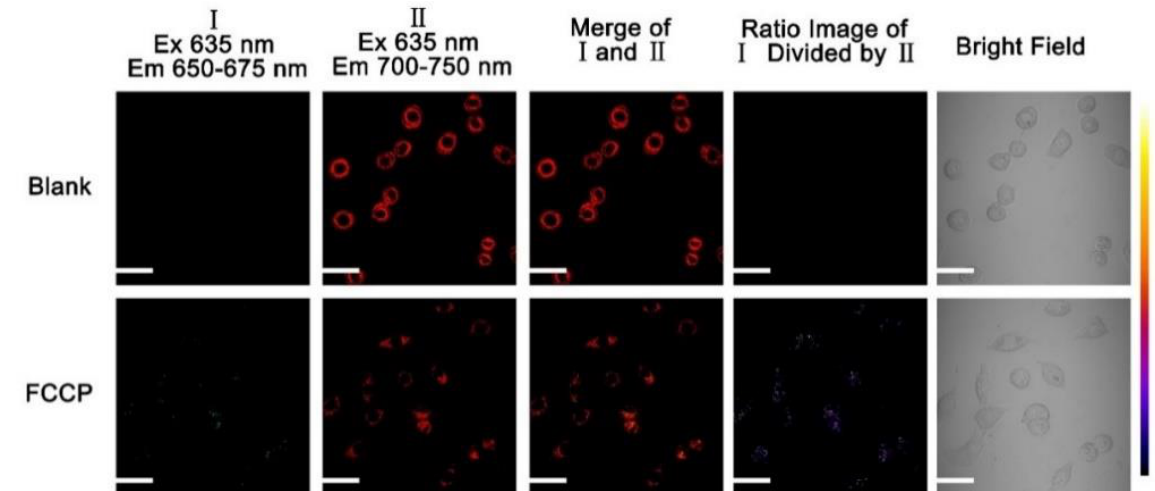
Figure 14. Fluorescence images of HeLa cells incubated with 10 µM probes AH + before and after FCCP treatment. The first and second channels in the fluorescence images were recorded from 650 nm to 675 nm, and from 700 nm to 750 nm under excitation at 635 nm, respectively. Scale bars: 10 µm . HeLa cells were incubated with 10 μM probe AH + for 20 min, and further treated with 10 μM FCCP in PBS 37 °C for 20 min. Live cell images were obtained by an Olympus IX 81 confocal microscope. ImageJ software was used to obtain ratiometric images. The software is free from https://imagej.nih.gov/ij/, 2 April 2021.